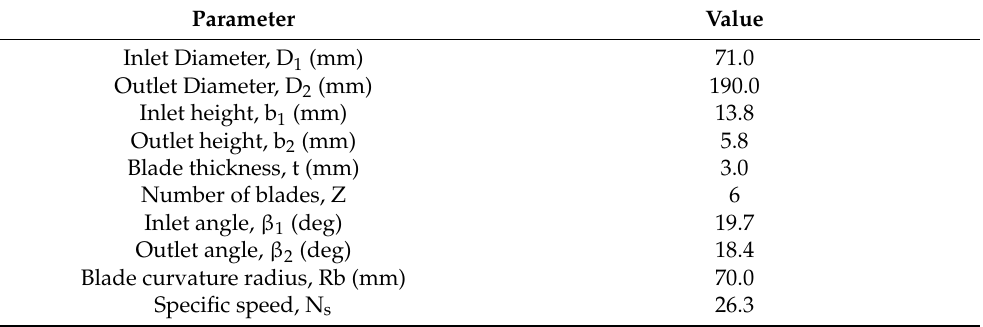
Figure 1. The geometry of the centrifugal impeller; ( a ) configuration of six-blade impeller; ( b ) computational domain. Table 1. Geometric specifications of the centrifugal impeller.